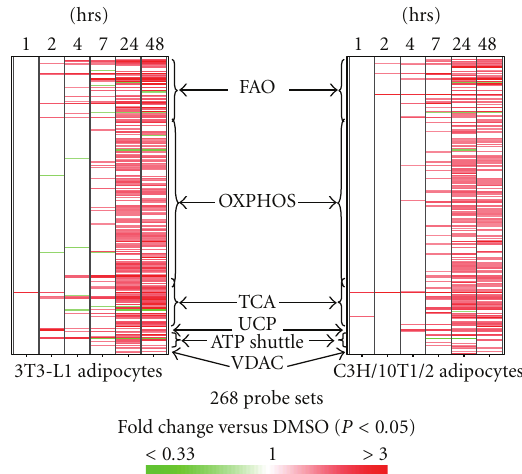
Figure 2: Transcriptional regulation of genes involved in mitochon- drial metabolic function. Shown is a heatmap of mean fold changes of probe set intensities in 3T3-L1 and C3H/10T1/2 adipocytes treated with RSG compared to DMSO over time ( n = 3 per time point in each cell type). Each row represents one probe set. The probe sets were grouped by their functions as indicated, and arranged in the same order for both cell types. Only fold changes significantly di ff erent ( P < 0 . 05) were shown in colors (red or